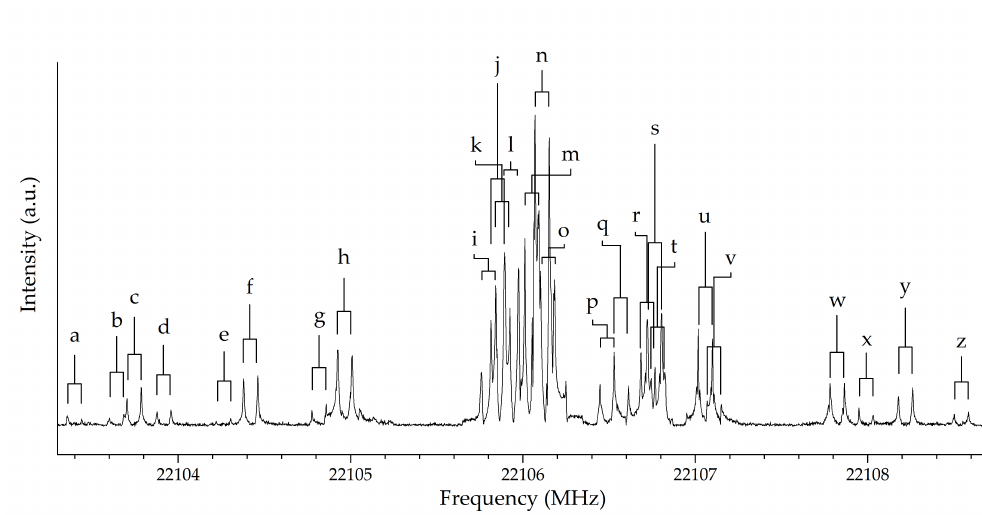
← 2 = 3 0,2 transition of 3-aminoisoxazole recorded 1,3 a , K c